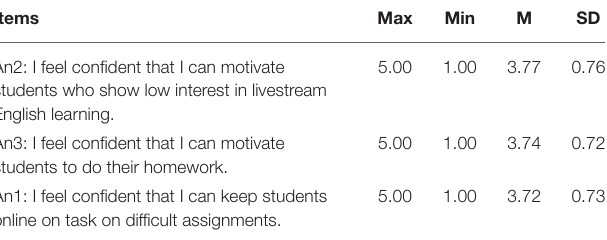
TABLE 6 | Descriptive analysis of technological self-efficacy scores. Items Max Min M SD An4: I feel confident that I can motivate my students to participate in the livestream class to support English learning.